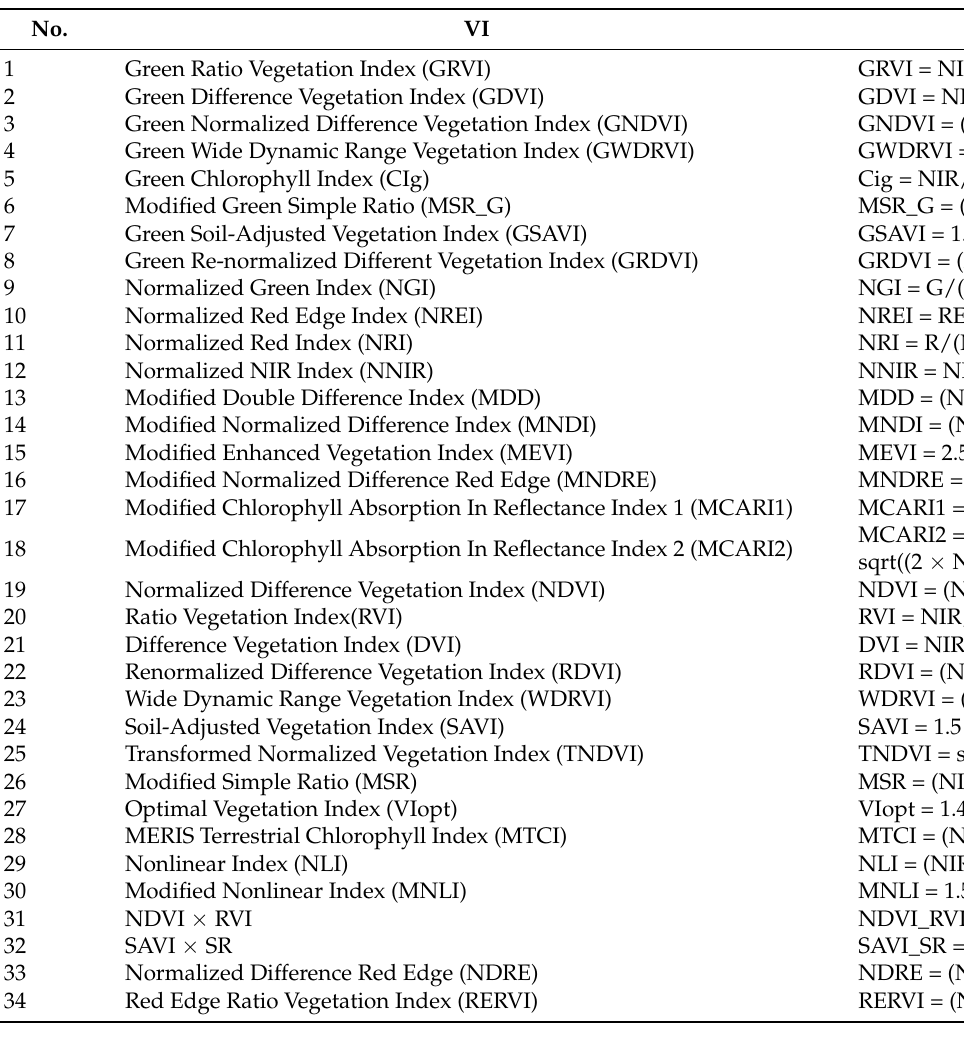
Table 2. VIs used in this